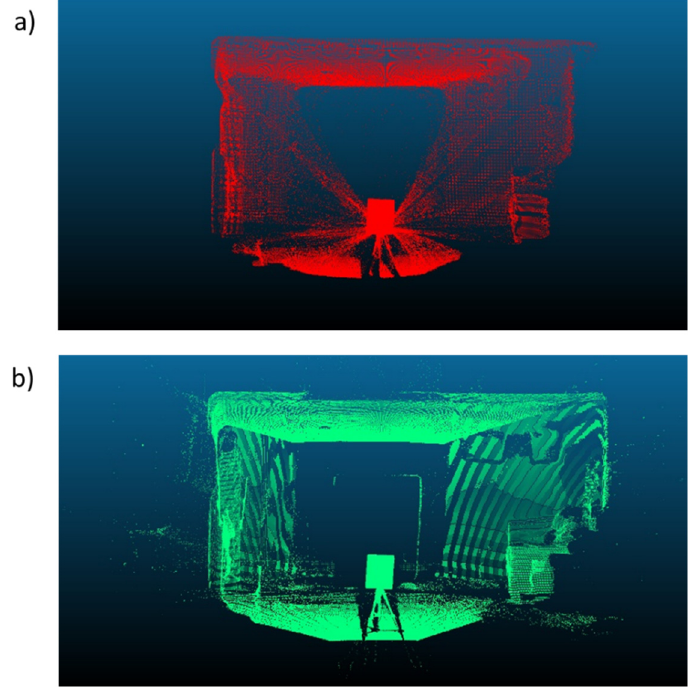
Figure 9. The point cloud generated from averaging 1000 consecutive depth frames for the ( a ) Kinect v2 and ( b ) Azure Kinect for the first board location. The smearing of points outward from the origin for the Kinect v2 is due to a lack of mask for the Kinect v2.